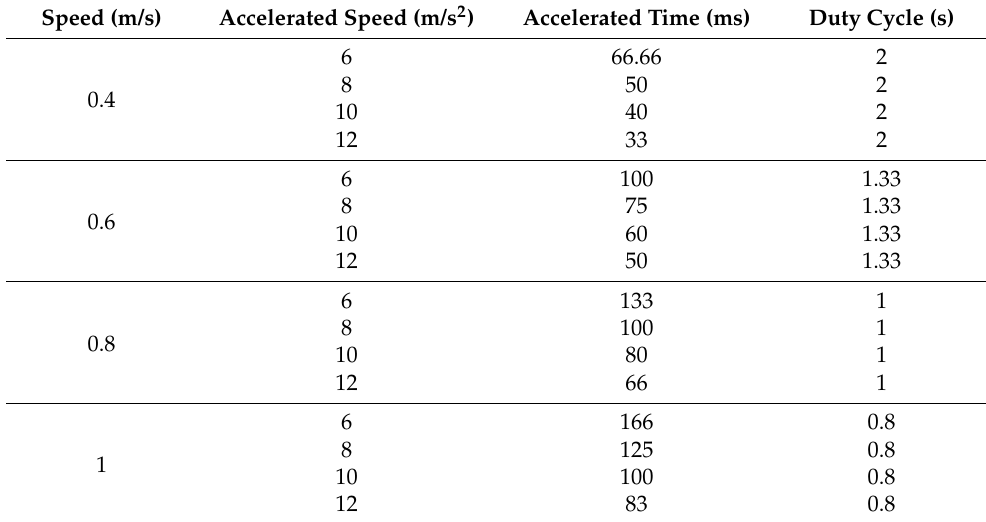
Table 1. Different excitation treatments applied to the actuator for the transportation of grape clusters.